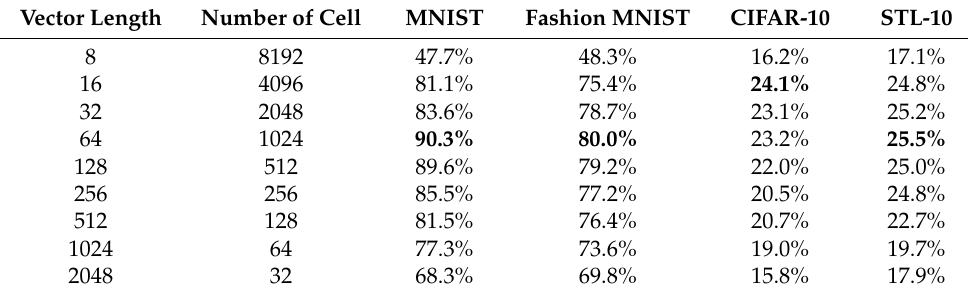
Table 2. Simulation result of image datasets with 64 KB of memory. Vector Length